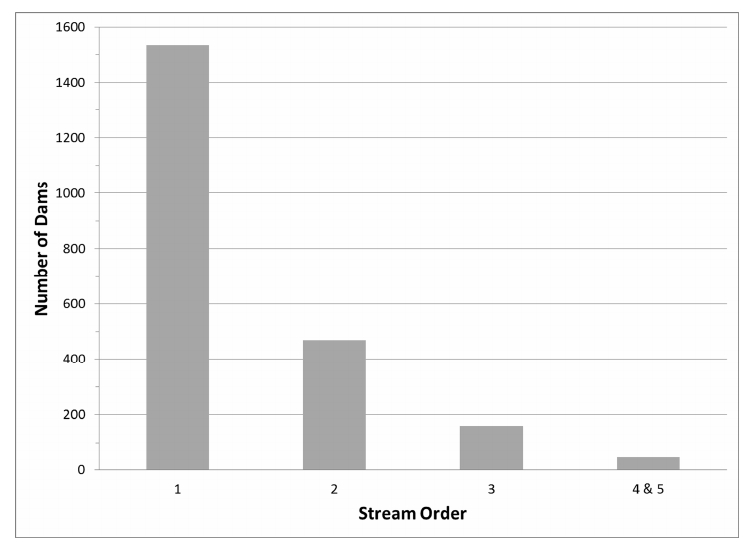
Figure 2. Number of 2206 N removal dams draining to the Atlantic from New England distributed by stream order.